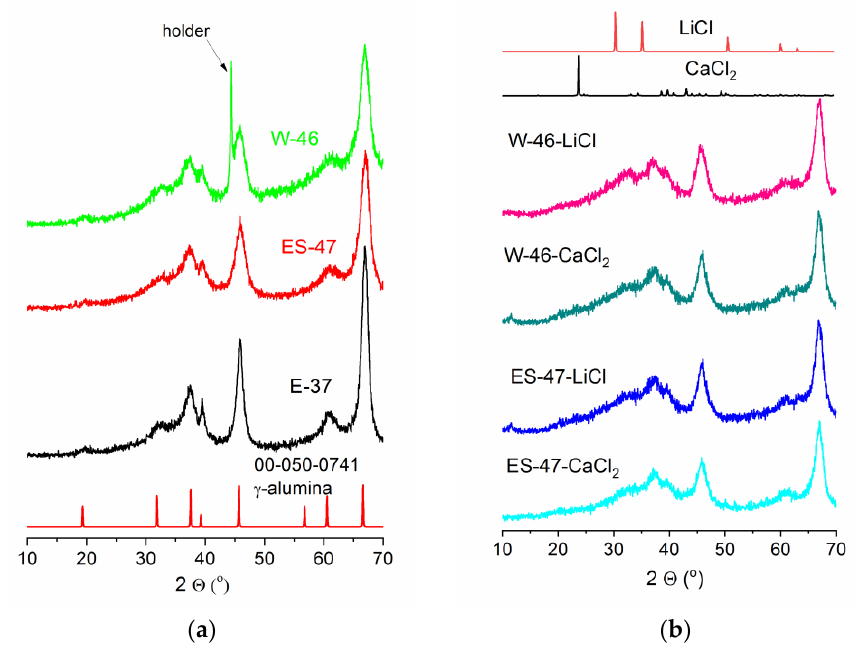
Figure 1. Powder XRD patterns of ( a ) γ -Al 2 O 3 products obtained after thermal treatment at 800 °C and ( b ) CaCl 2 and LiCl composites with W-46 and ES-47 γ -Al 2 O 3 supports.